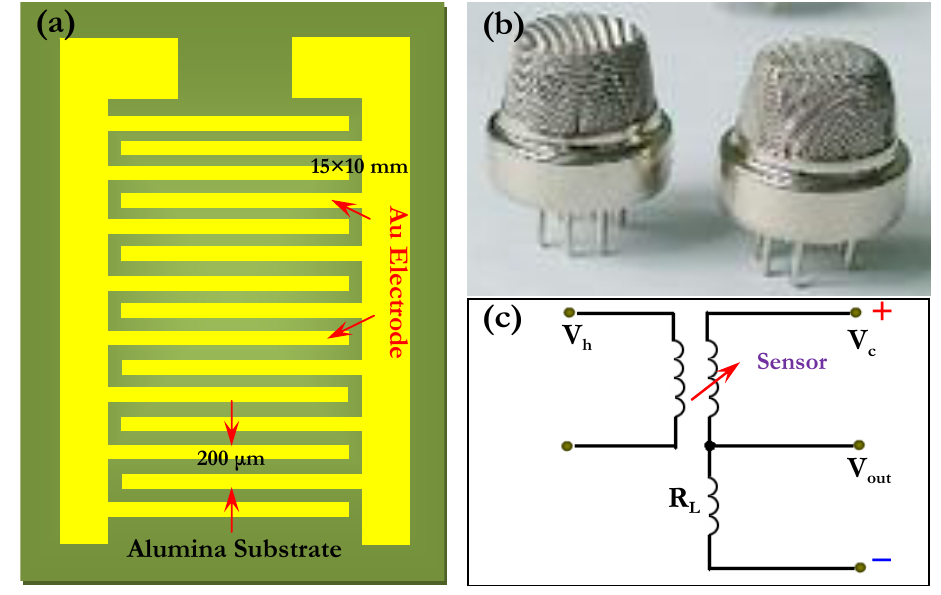
Figure 1. Schematic of a thick-film gas